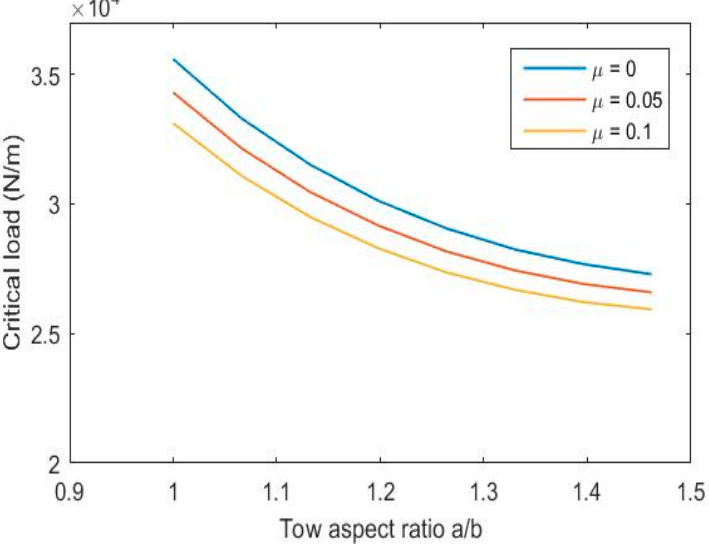
Figure 9. The variations of critical load versus different plate aspect ratios for various initial defect coefficients.